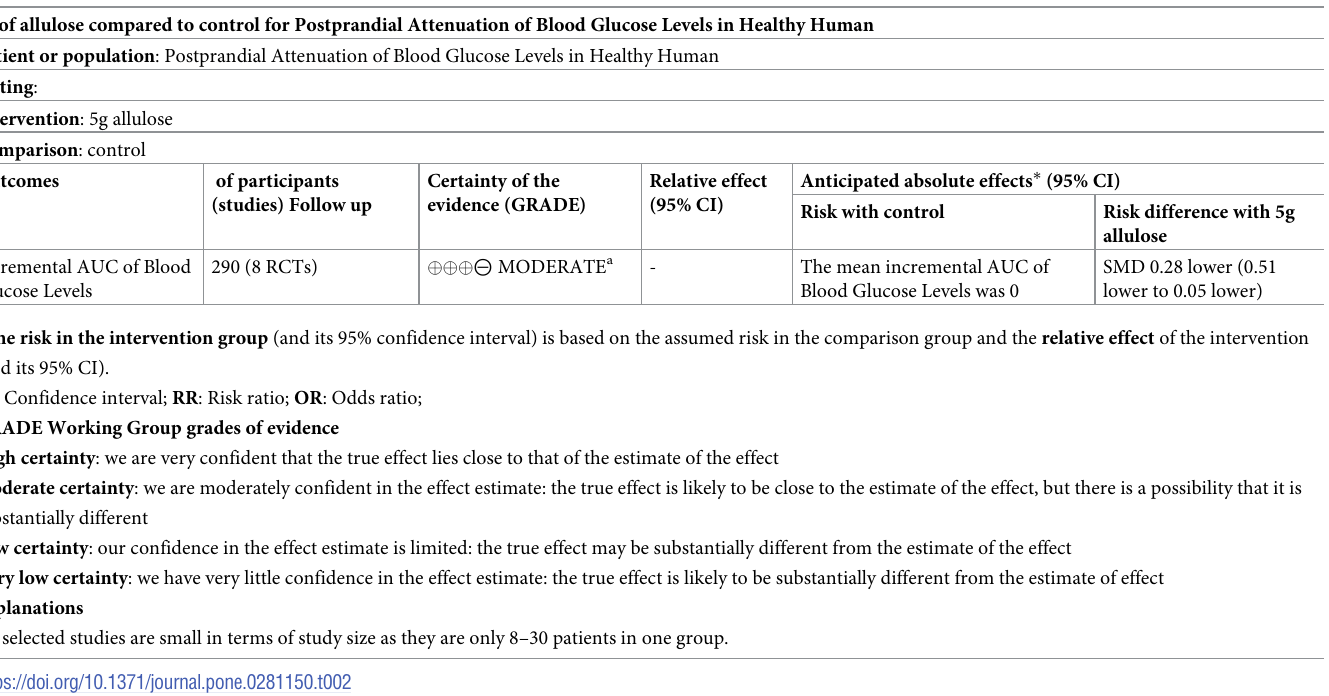
Table 2. Summary of findings for 5g of allulose